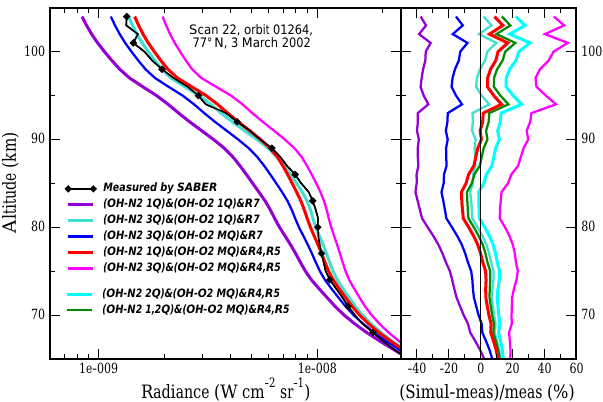
Figure 2. Left: measured and simulated SABER nighttime radi- ances in channel 7 (4.3µm) for SABER scan 22, orbit 01264, 77 ◦ N, 3 March 2002. SABER measured (black); see Sect. 2.3 for a de- scription of calculation scenarios displayed in the legend. Right: ra- diance relative difference (simulated − measured) / measured in per-